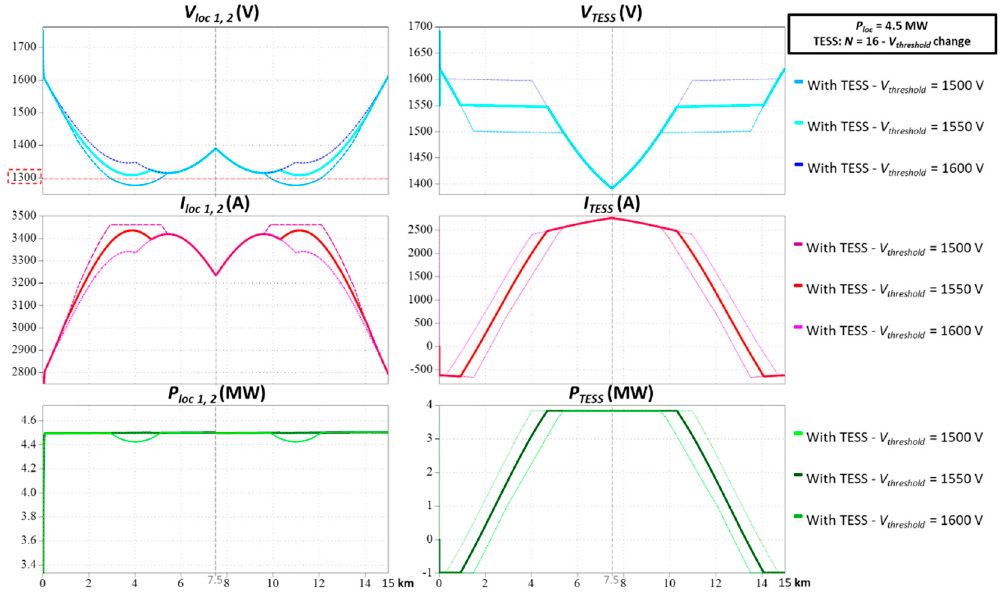
Figure 9. Simulation results according to the location of the crossing point of locomotives 1 and 2 in the sector. Analysis of the in fl uence of V threshold ( N = 16; P loc = 4.5 MW).